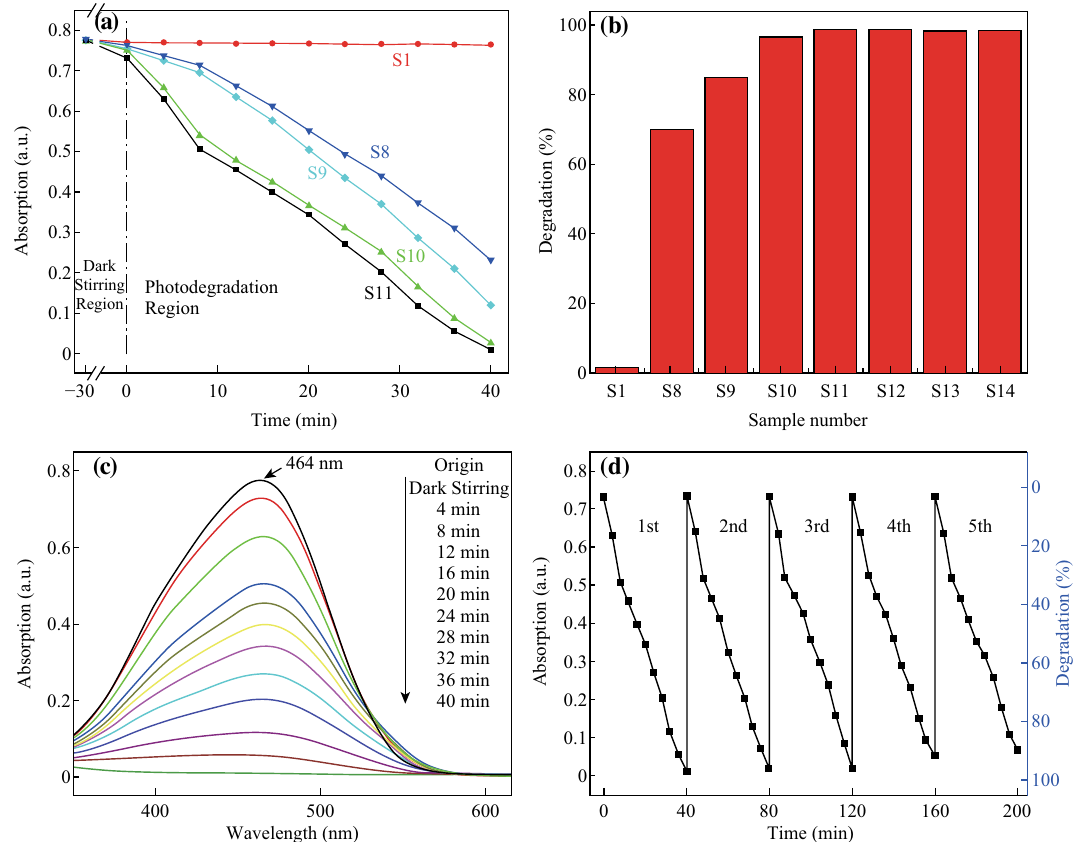
Fig. 7 a Comparisons of degradation rate with different samples in different stages; b comparisons of photocatalytic activities among the Ag– AgBr@TiO 2 NPAS samples with different R and TiO 2 NPAS sample under the visible light irradiation in 40 min; c absorption spectrums of the degradation with sample S11 in different stages; d the result of the repeated experiments for five times with sample